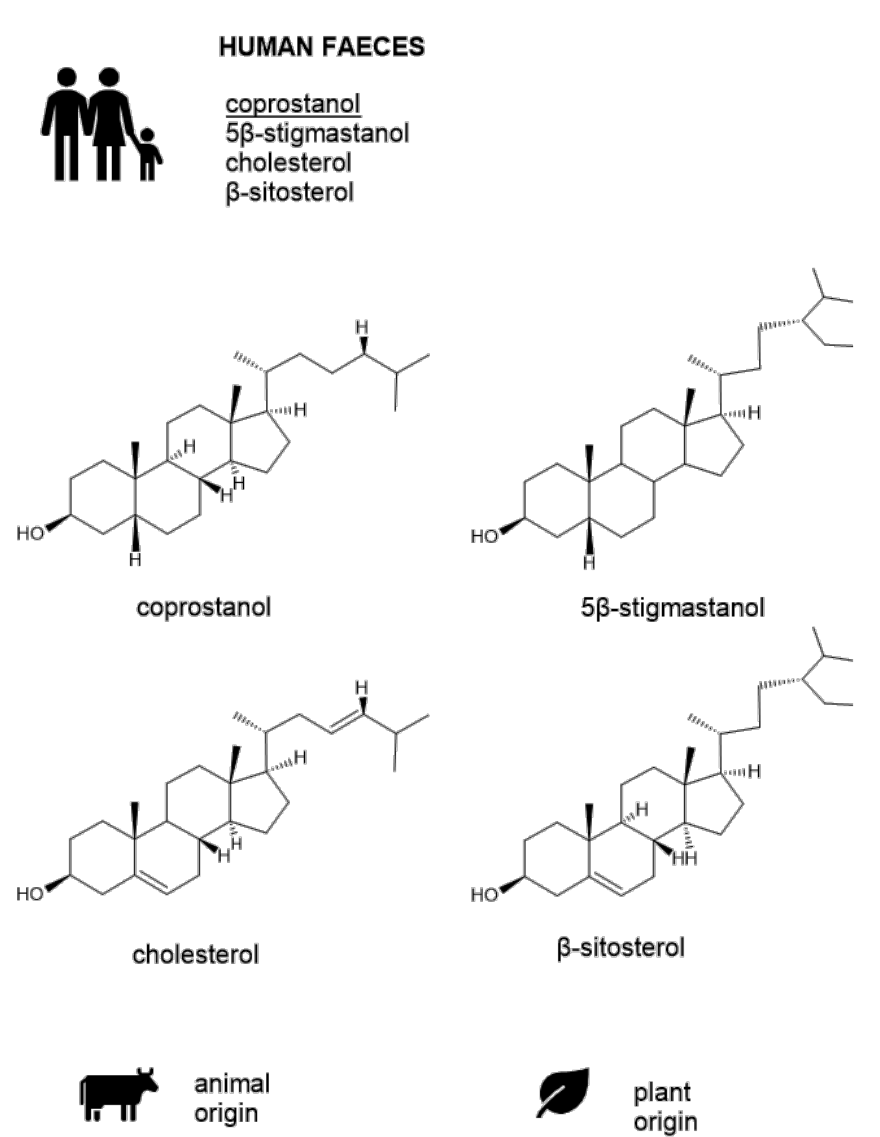
Figure 1. Indication of the major sterols in human faeces (according to Prost et al. 2017 [34]). During the archaeological excavation in 2017 at the Rossio square (Praça D. Pedro